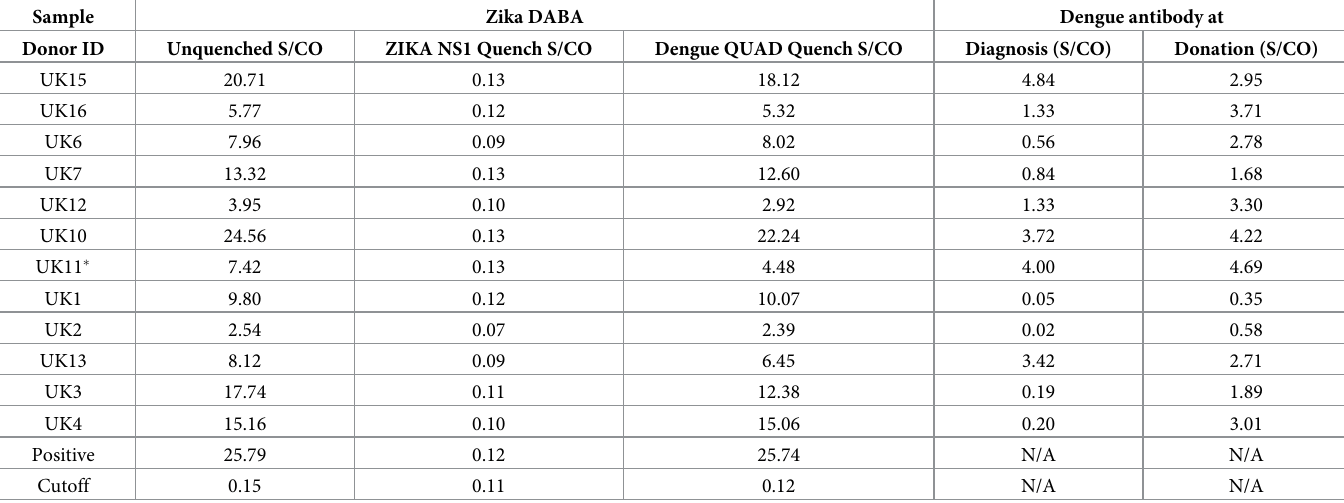
Table 4. Zika and Dengue antibody reactivity in samples from UK returning travellers.